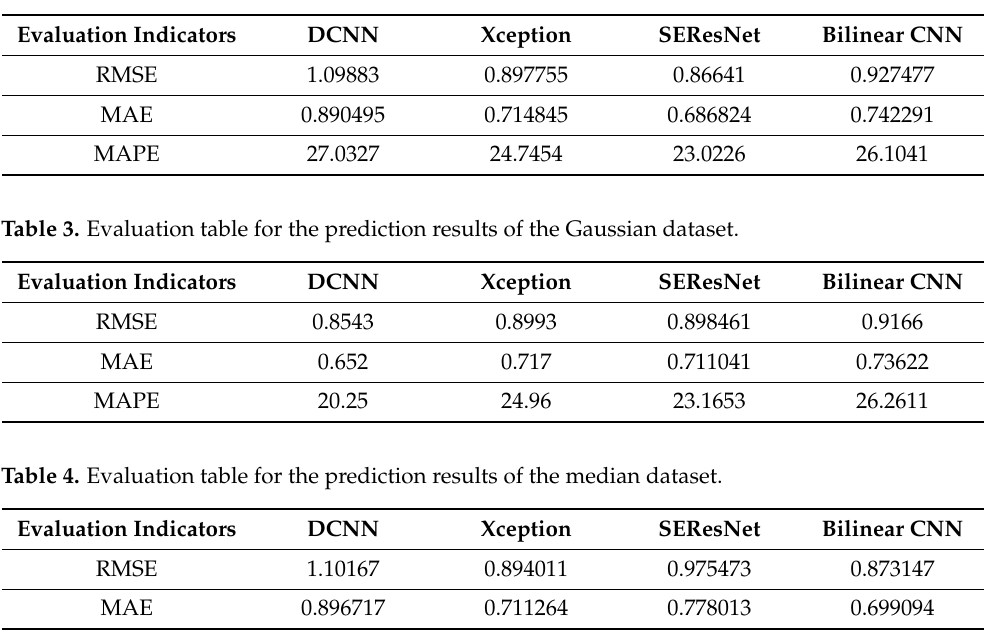
Table 2. Evaluation table for the prediction results of the original dataset.